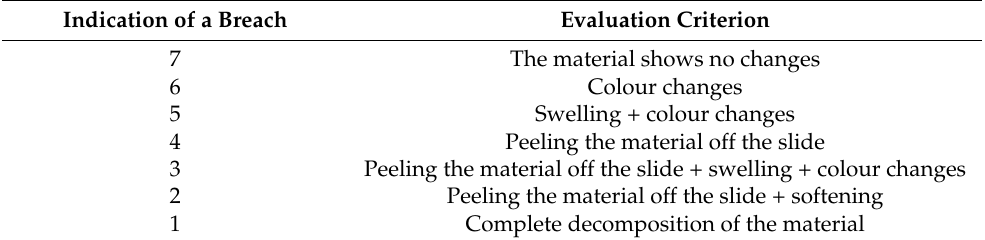
Table 5. Evaluation system for accelerated chemical resistance test designed with regard to the expected behaviour of the epoxy composites in the aggressive media. Indication of a Breach Evaluation Criterion 7 The material shows no changes 6 Colour changes Swelling + colour changes Peeling the material off the slide Peeling the material off the slide + softening Complete decomposition of the